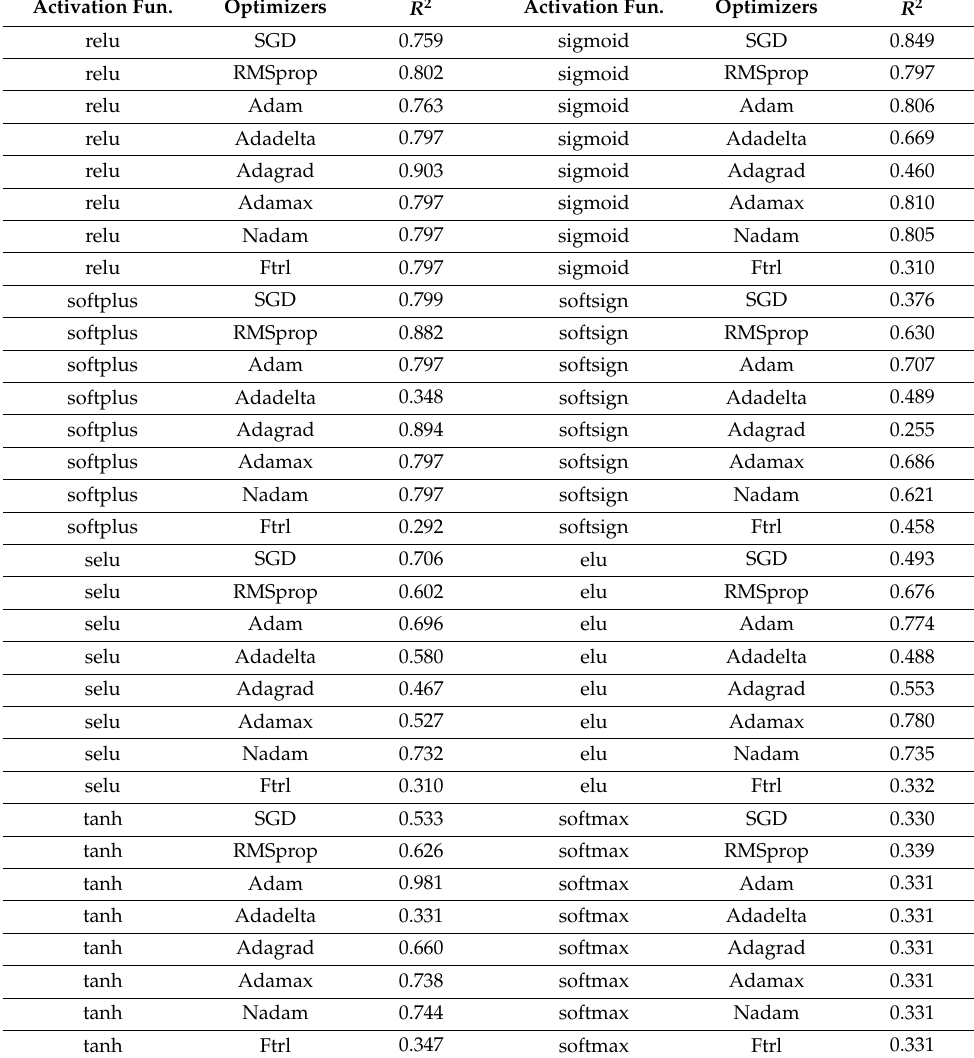
Table 3. Results of the various activation functions and optimizers for sub-model 6. Activation